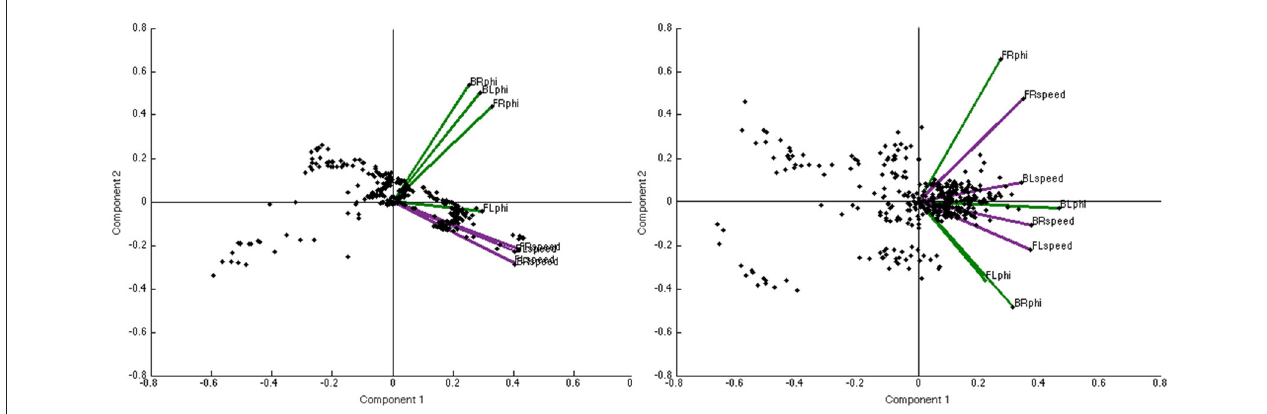
FIGURE 3 | Sample biplots of PC coefficients for a real group trial (Left) and a virtual group trial (Right) . These offer a representation of both the observations and variables of PC coefficients with the proximity of each trend line corresponding to the coefficient values for that particular variable.